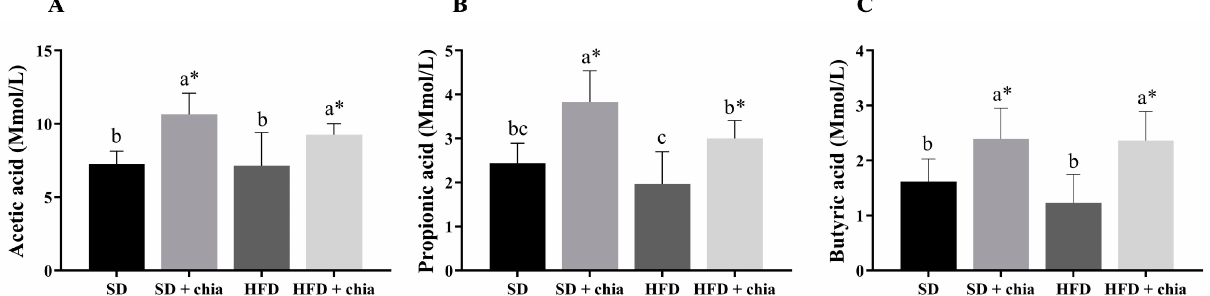
Figure 1. Short-chain fatty acid (SCFA) concentration in cecal contents of young Wistar rats, after 35 days of treatment (n = 8). ( A ) Concentration of acetic acid; ( B ) concentration of propionic acid; ( C ) concentration of butyric acid. SD: standard diet; SD+chia: standard diet + chia; HFD: high-fat diet; HFD+chia: high-fat diet + chia. The data were analyzed by one-way ANOVA. Means followed by different small letters in the same row differ significantly, according to Newman–Keuls post hoc test, at 5% threshold of probability. * Indicates differences between the groups by the t-test, at 5% probability, in the comparison of the groups that received the same diet, either with or without chia (SD × SD+chia and HFD × HFD+chia).